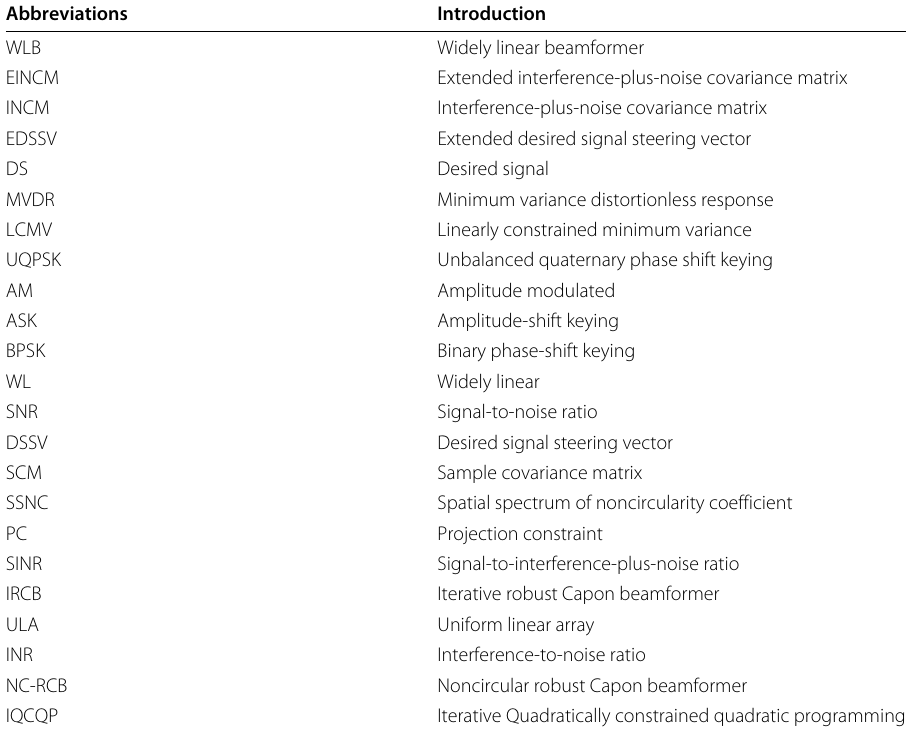
Table 2 Introduction to the abbreviations used in this